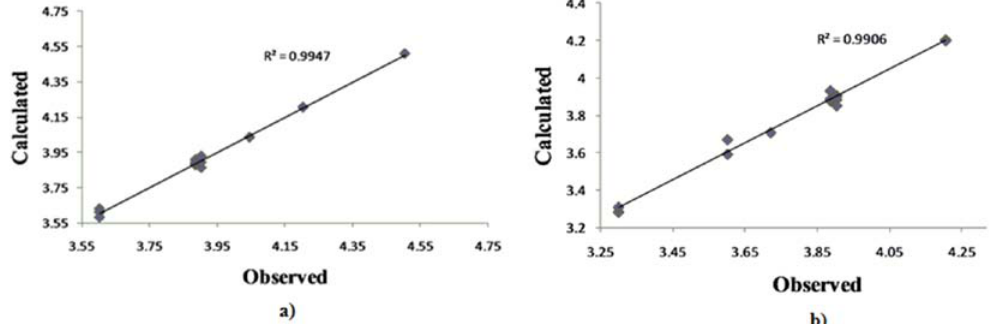
Figure 2. Plot of observed vs. calculated – log MIC values of the training set compounds obtained from a) Equation (1), b) Equation